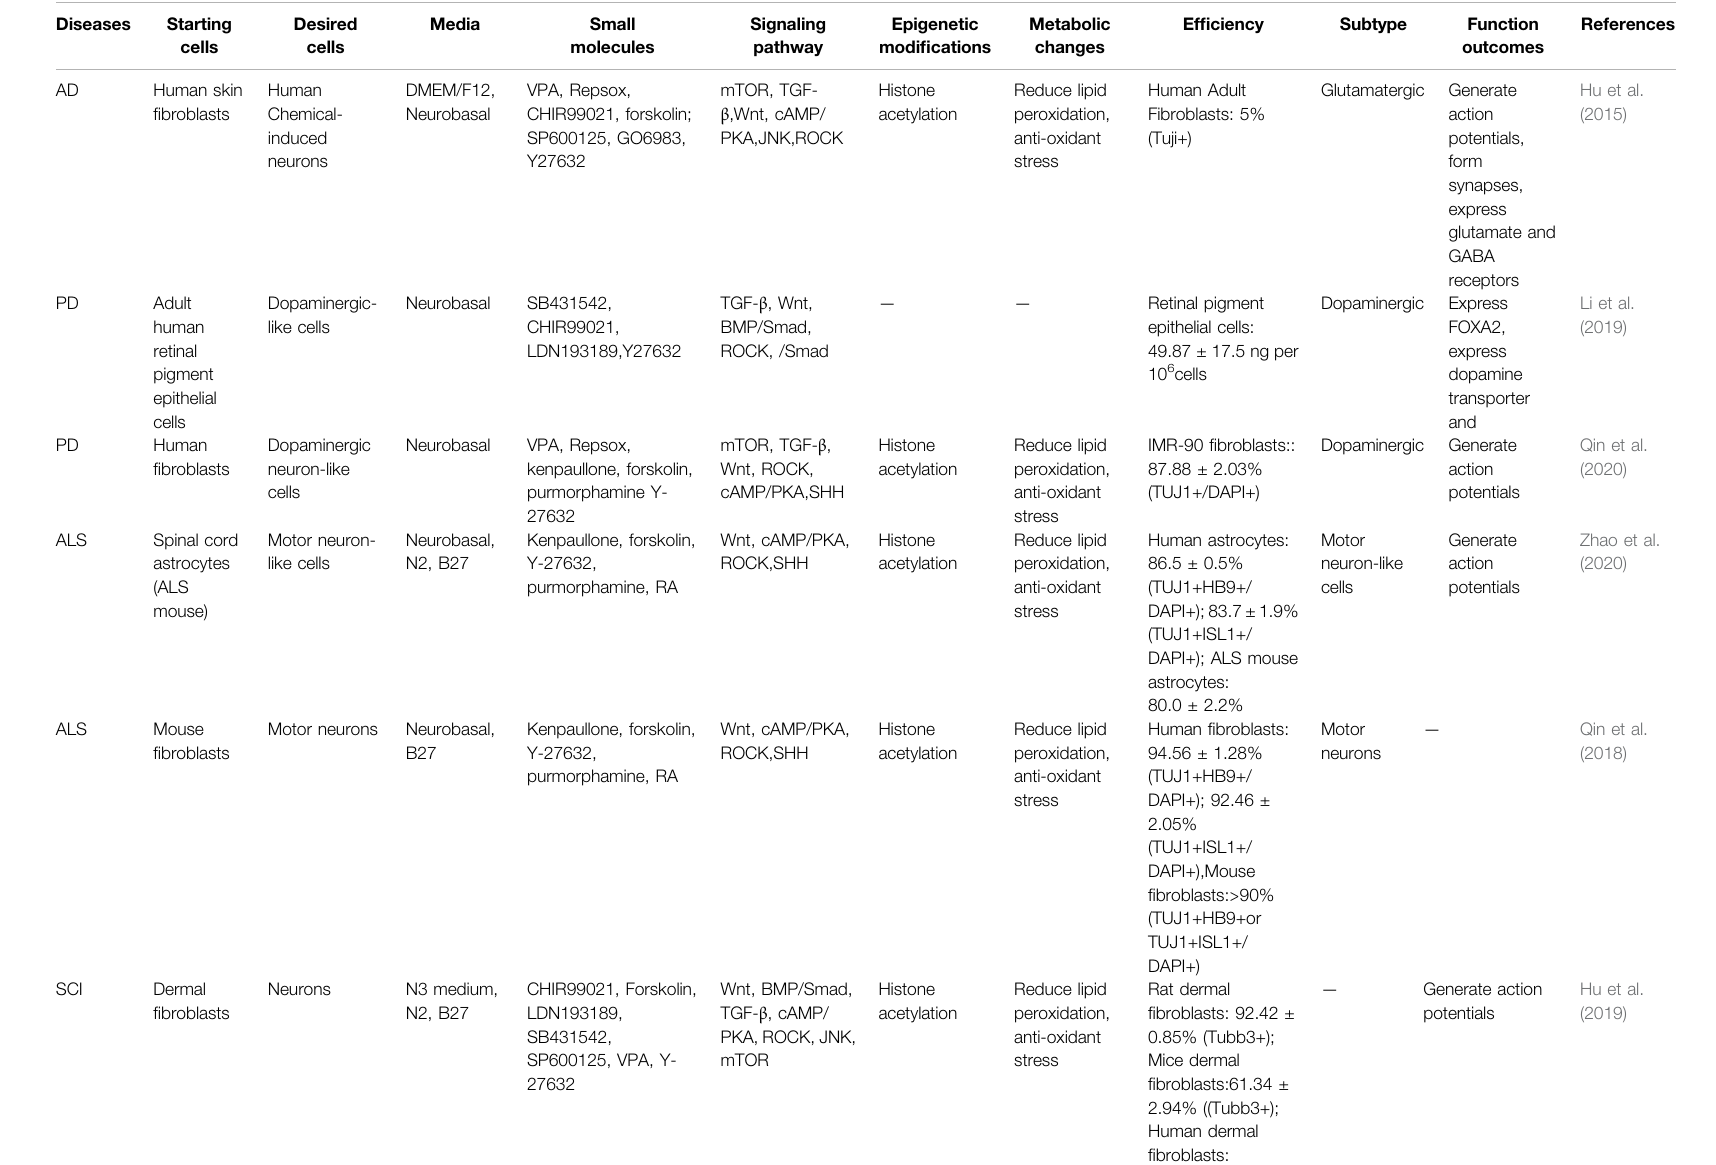
TABLE 3 | Direct neuron reprogramming in neurological disease by small